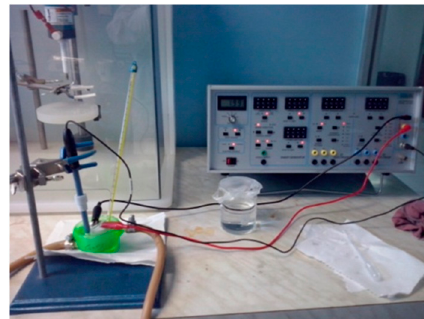
Figure 1. Experimental assembly used for electropolishing and anodizing processes.